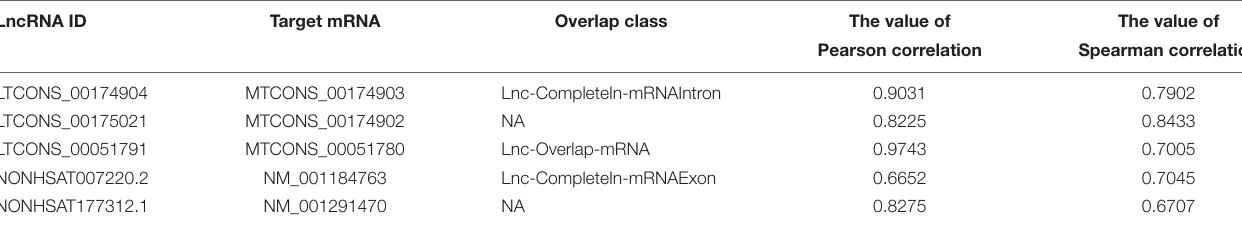
TABLE 2 | The classification of overlap of